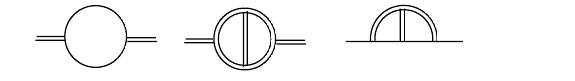
Figure 6 . Three examples of diagrams that are suppressed in the large- n limit when g (cid:24) 1 =n . From left to right they scale as g 2 n , g 4 n 2 and g 4 n 3 respectively.